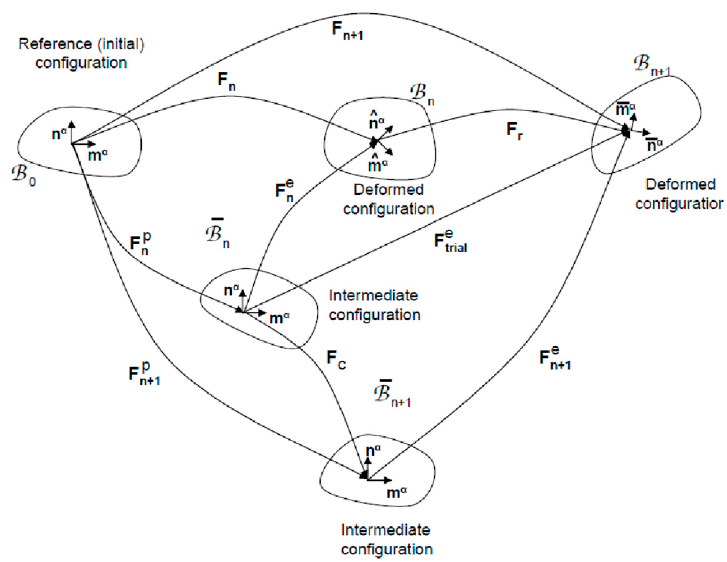
Figure 3. Different configurations of the body in finite strain framework (After Yaghoobi et al. [103]).